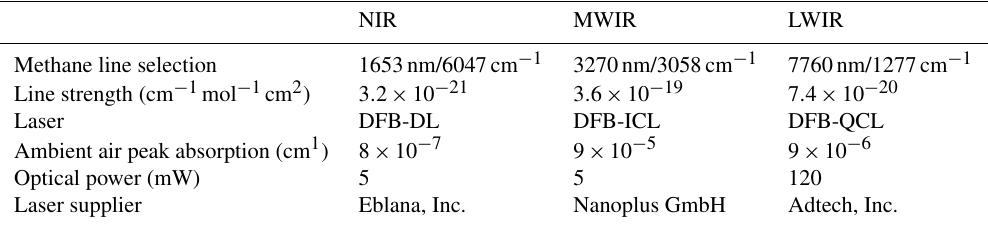
Nanoplus GmbH Adtech,